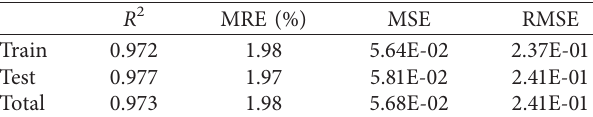
Figure 5: Relative deviation analysis to evaluate the accuracy of the proposed model in predicting the target parameter. Table 1: Statistical parameters calculated to evaluate the proposed